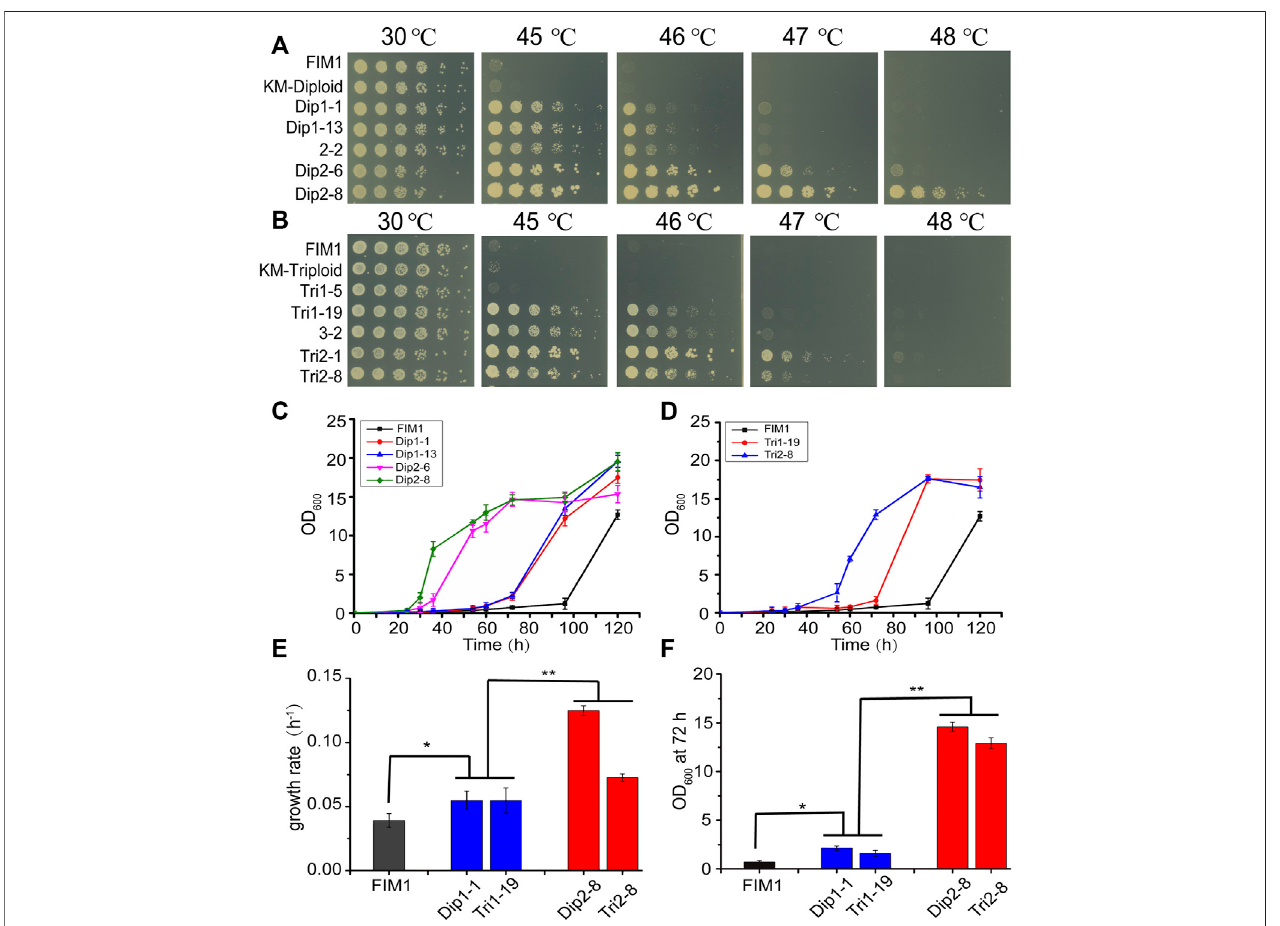
FIGURE 2 | Comparison of the thermotolerant spores generated by diploid and triploid strains. (A, B) Spot assays of the thermotolerant spores generated by diploid strains (A) andtriploidstrains (B) . (C,D) Thegrowthcurvesofthethermotolerantsporesgeneratedbydiploid (C) andtriploidstrains (D) at47 ° C.Valueshereand below represented mean ± SD (n (cid:1) 3). (E) The maximum growth rate of representative spores generated by diploid and triploid strains at 47 ° C. (F) OD 600 of representative spores at 72 h. The signi fi cant difference was measured by a Student ’ s t -test. * p < 0.05, ** p <